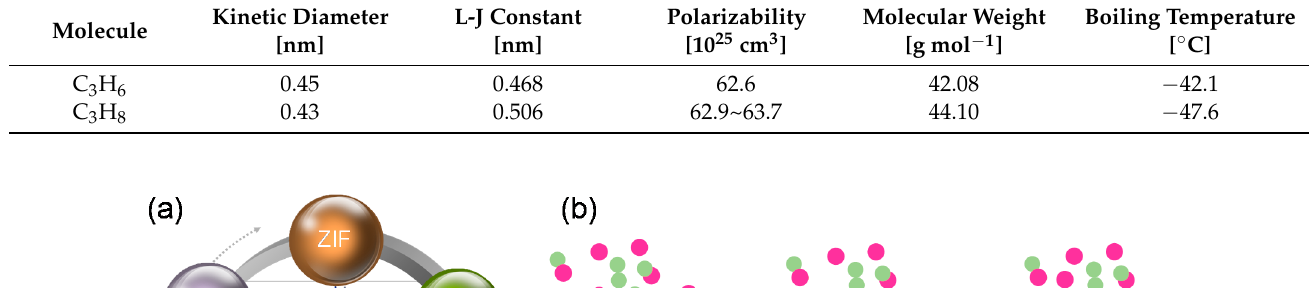
Table 1. Summary of physical properties of C 3 H 6 and C 3 H 8 molecules.